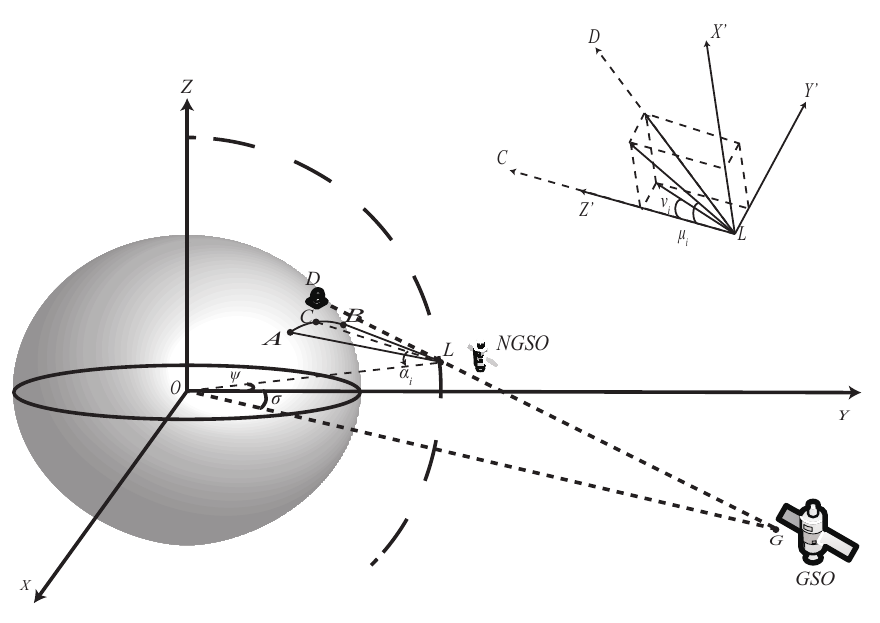
Figure 2. Downlink inline interference from NGSO satellite to GSO earth station. The off-axis angles of point D with respect to the major-axis and minor-axis directions of beam b i are denoted as ν i and µ i respectively. The LEO satellite is located in the YOZ plane, and the longitude difference is σ between the GSO satellite and it. The EPFD of point D is shown as